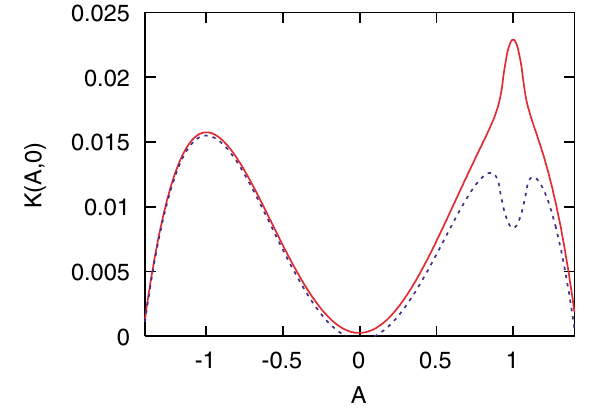
FIG. 9. (Color) Schematic plot of K (cid:3) A; B (cid:1) 0 (cid:4) . The solid red line corresponds to a defocusing impedance with ‘ > 0 and the soliton centered at A (cid:1) 1 , B (cid:1) 0 . The blue dashed line corre- sponds to a focusing impedance with ‘ < 0 and the soliton centered at A (cid:1) 1 , B (cid:1) 0 .